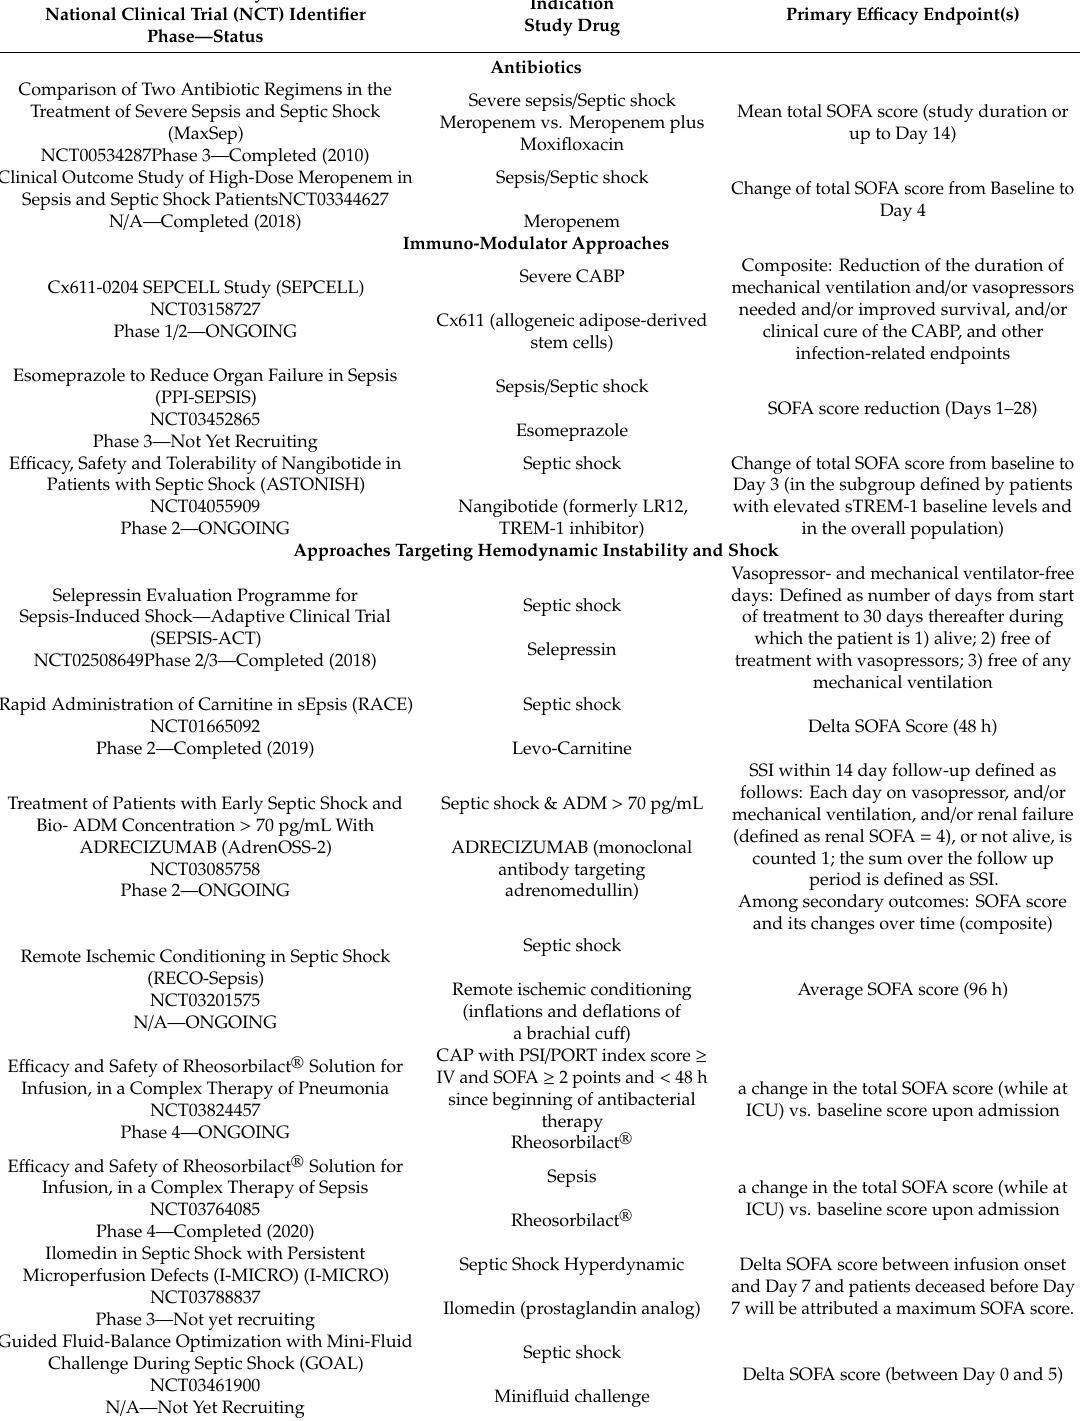
Table 1. Examples of recent or current clinical studies in severely infected